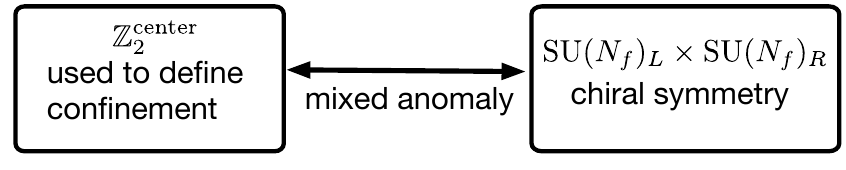
Figure 2 . Mixed anomaly between Z center